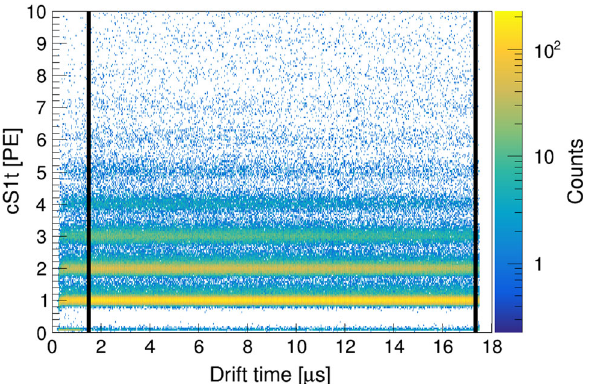
Fig. 8 Corrected S1t vs. drift time histogram with the single photo- electron band